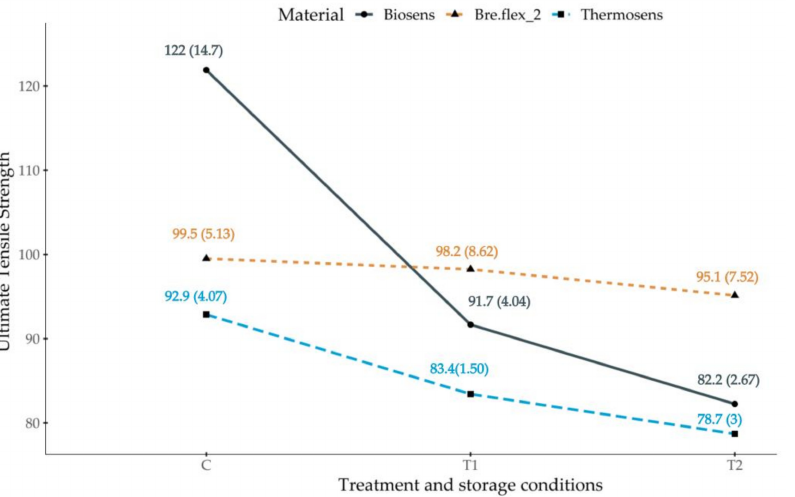
Figure 4. Treatment and storage conditions, and material as ultimate tensile strength predictors. Mean and standard deviation values in brackets () are presented for each